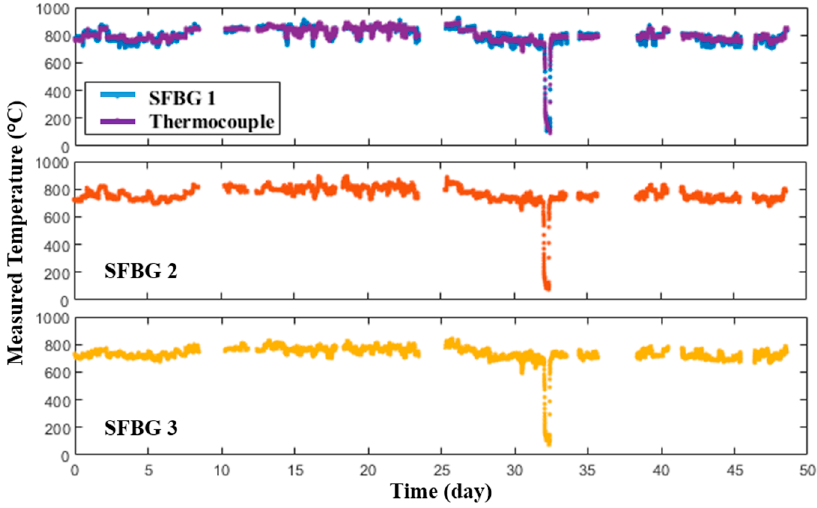
Figure 10. Temperature response of the sensor in a commercial gas-fired boiler over 48 days.